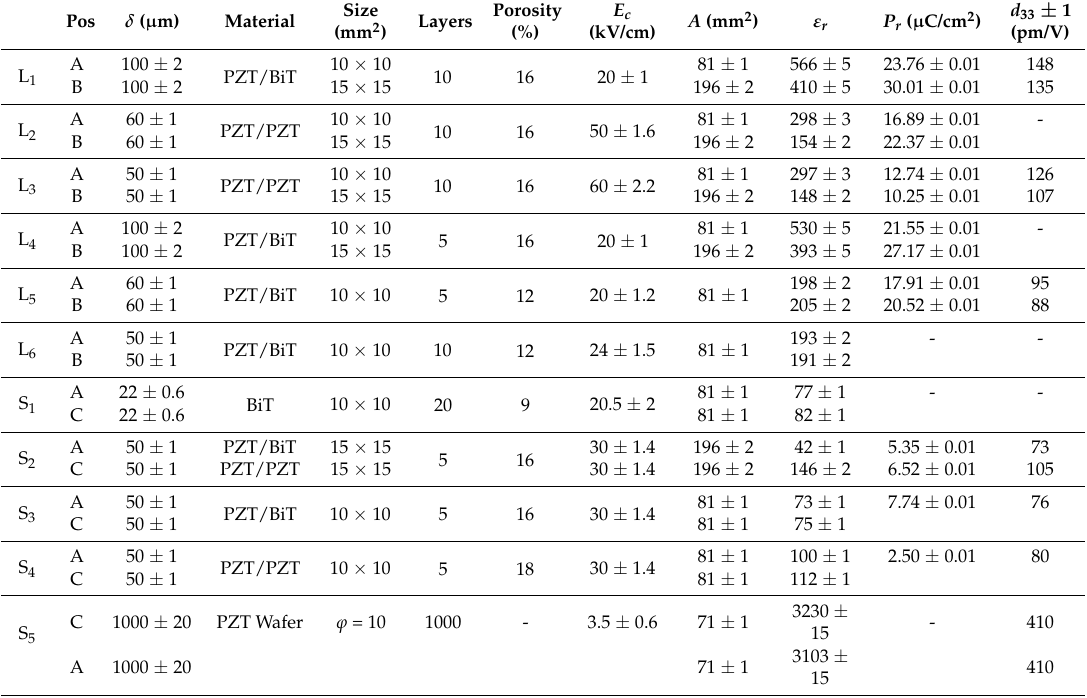
Table 4. Characterization results of piezoelectric films over the S and L